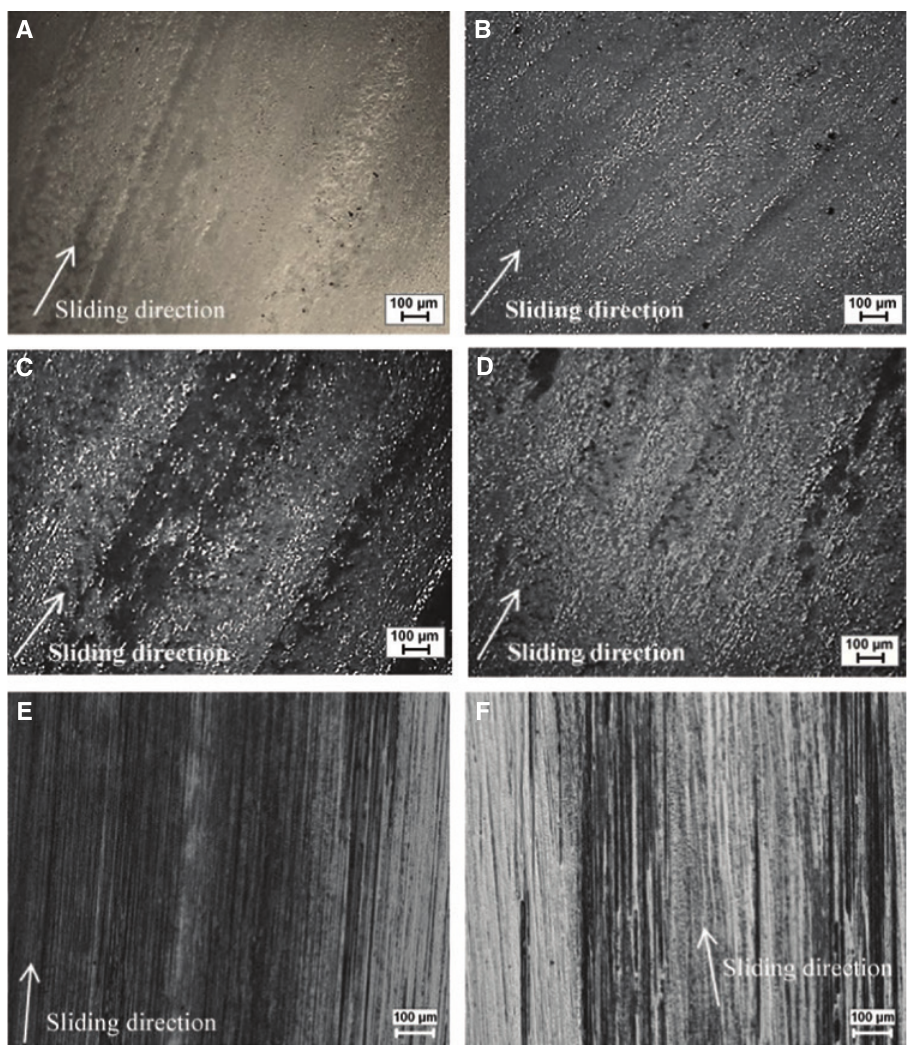
O epoxy composites at 0.4 m/s sliding speed and 15 N load condi- 2 3 O -filled epoxy composite, (C) worn pin surface of 5 wt% 2 3 O -filled epoxy composite, (E) worn disc surface of pure epoxy, 2 3